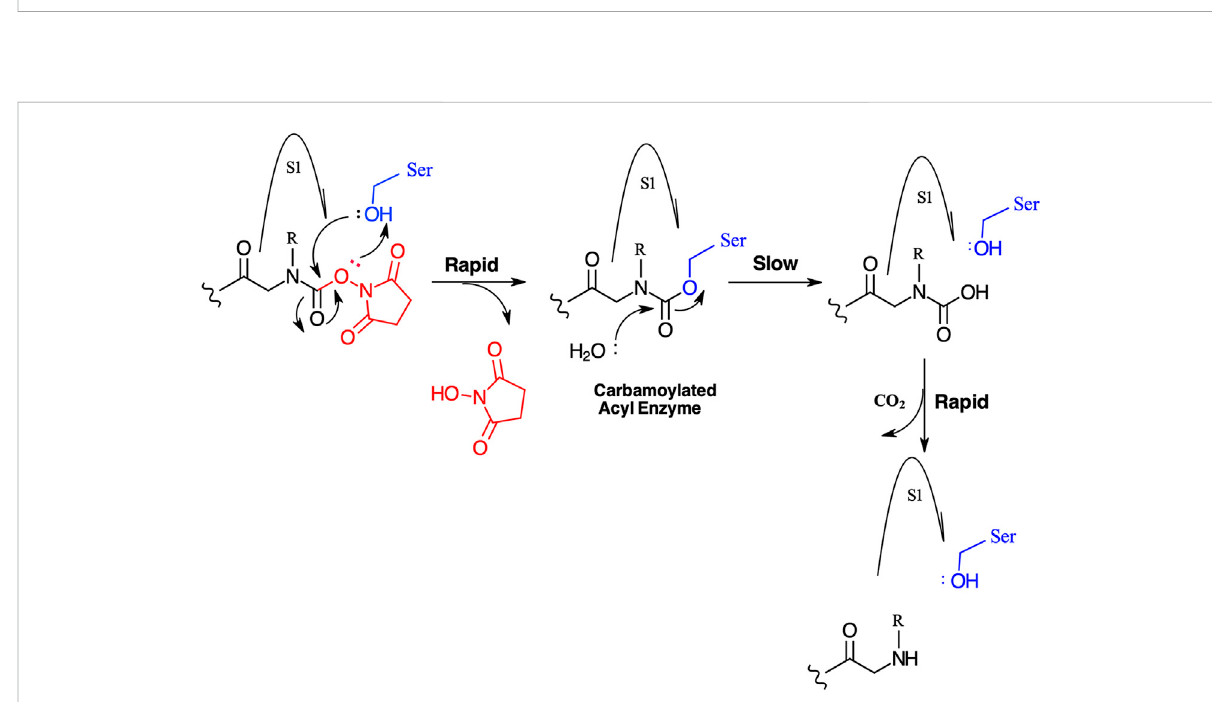
FIGURE 11 Postulated mechanism for the inhibition of serine proteases by N -alkyl glycine NHS